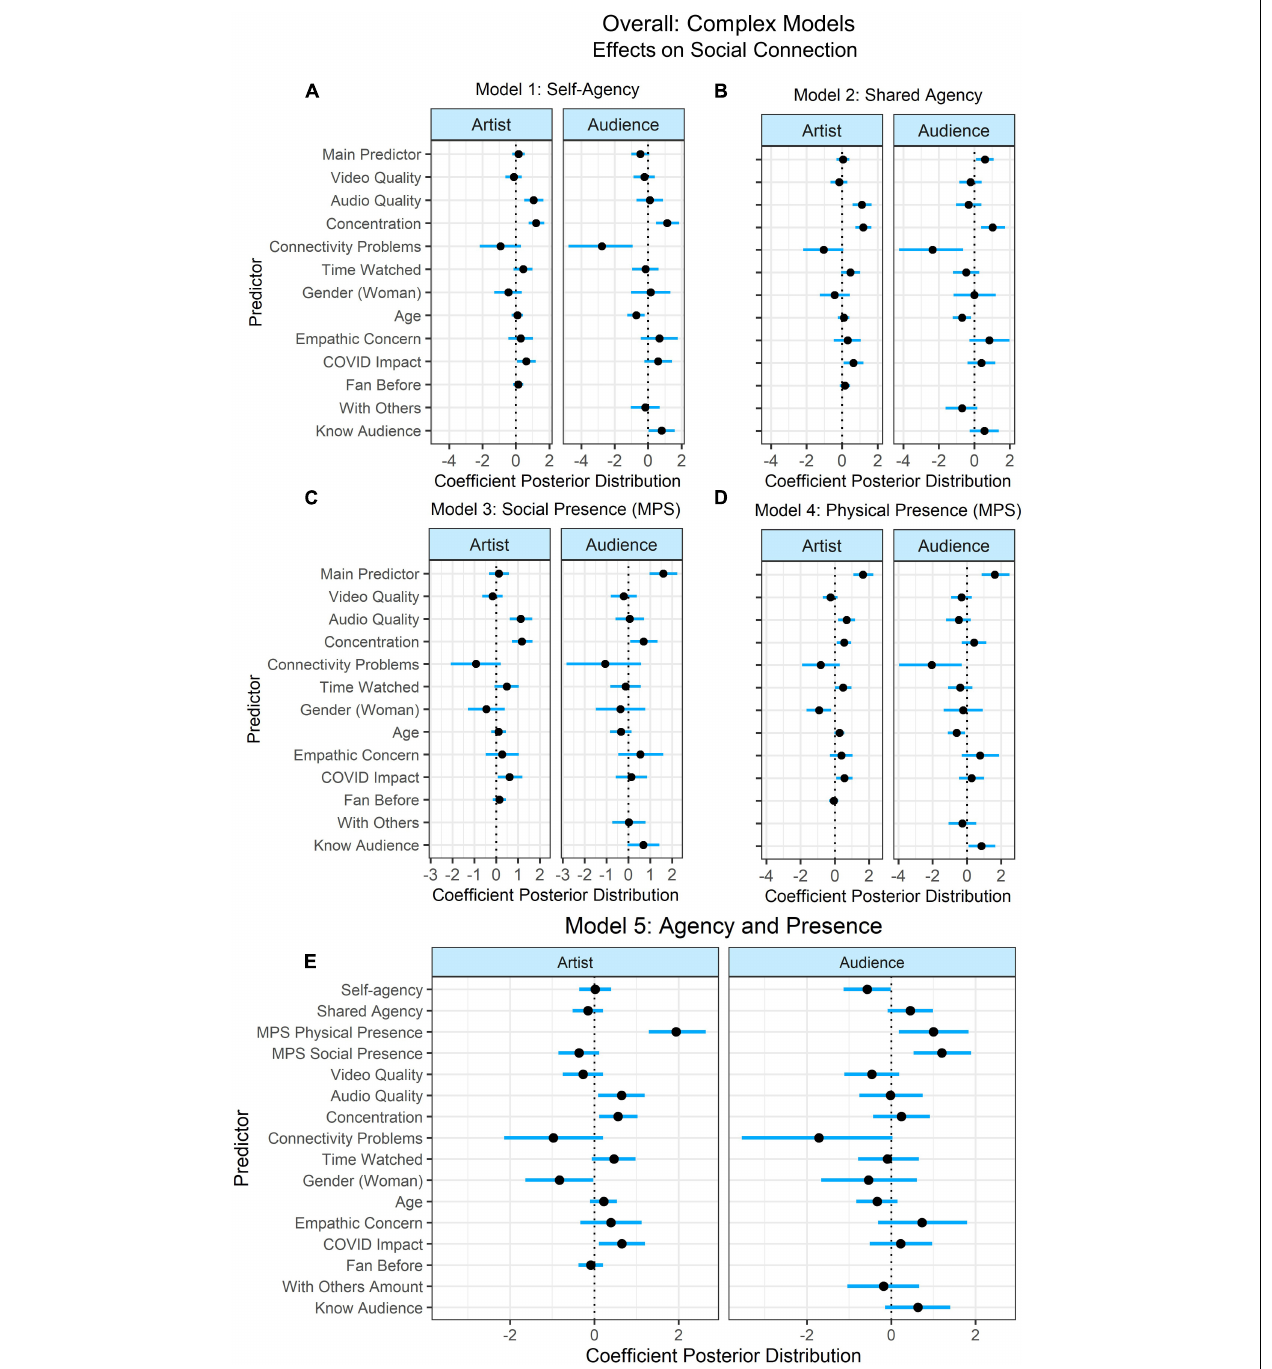
FIGURE 9 | Overall complex models’ predictor coefficient estimates and 90% credible intervals using data from all concerts to determine the effects on social connection to the artist (left) and audience (right). Five models were fit to examine the individual contribution of the variables of interest: (A) Self-agency, (B) Shared Agency, (C) Social Presence, and (D) Physical Presence, and the combined effects of all predictors (E).